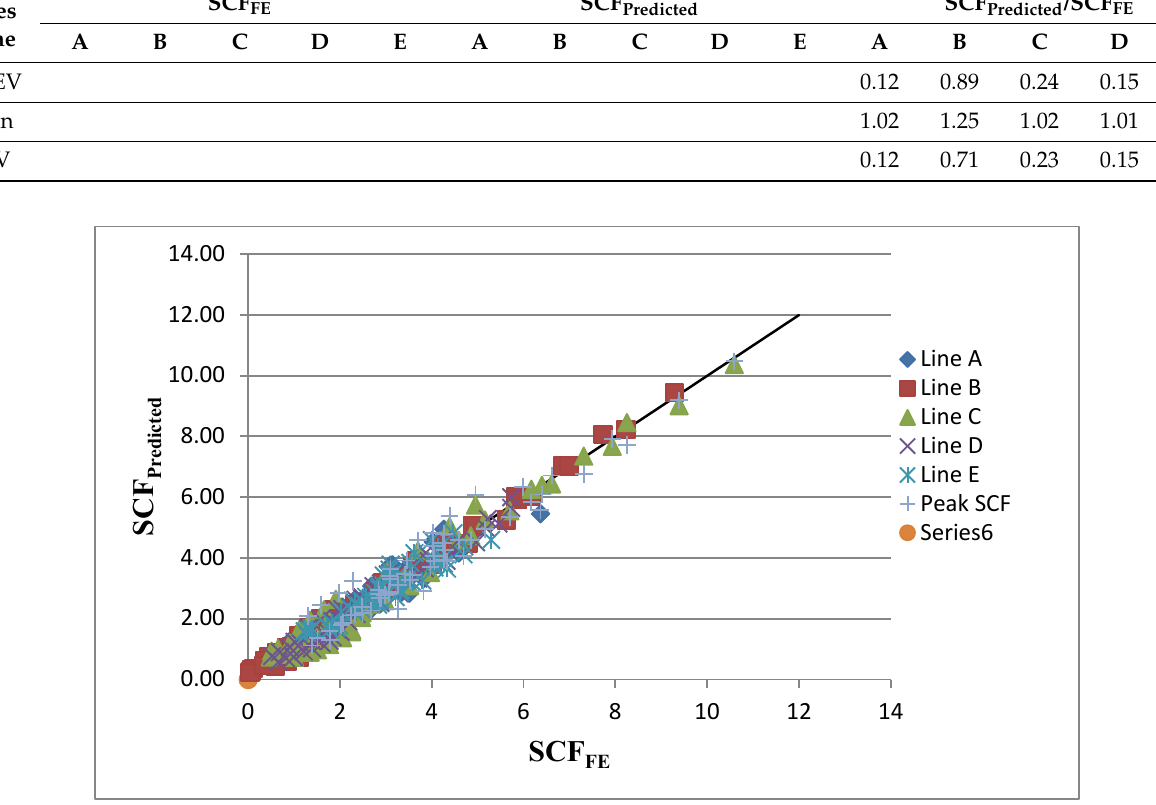
Figure 14. Comparison of SCFs from the predicted design equations and FEA.